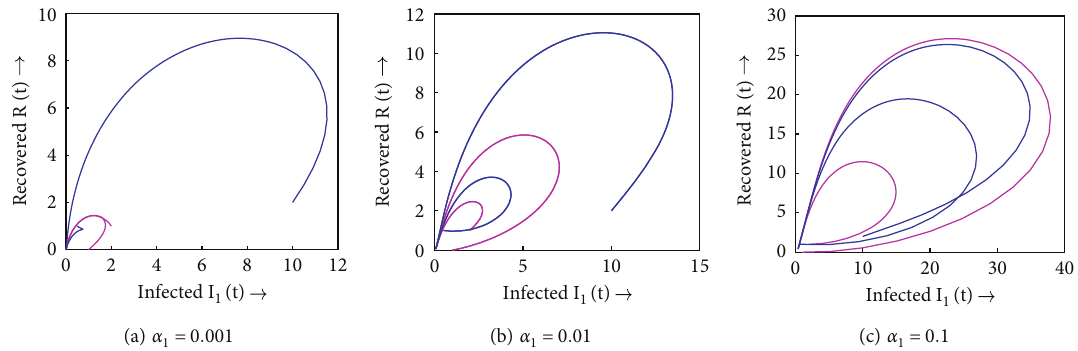
Figure 35: Phase portrait for Hopf bifurcation with di ff erent values of infection rate α